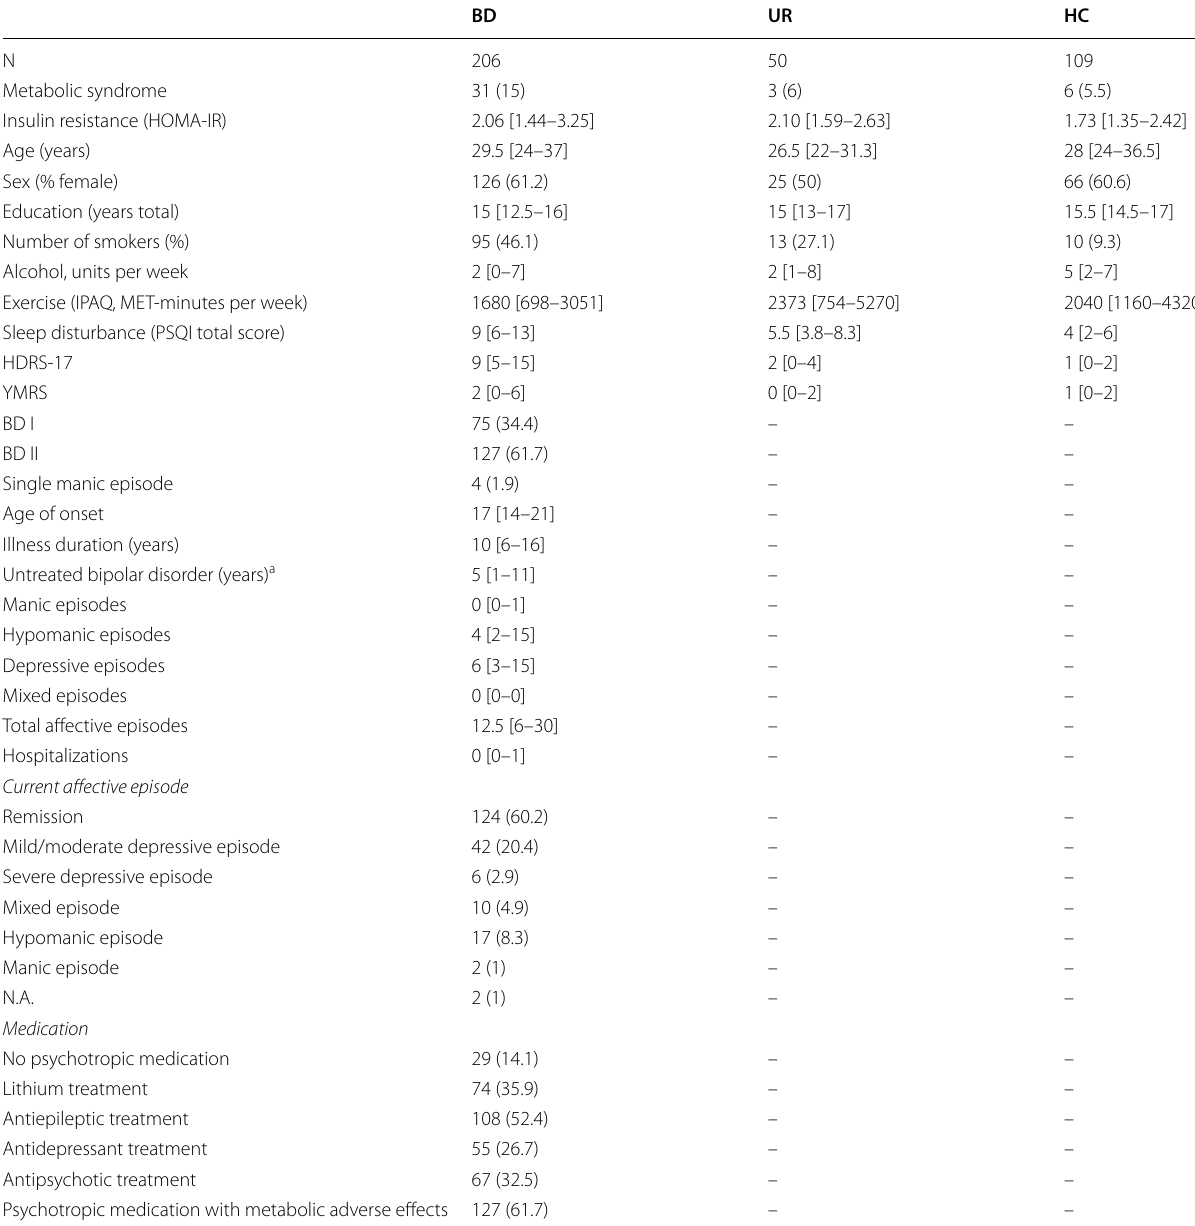
Table 1 Demographic and clinical variables in patients with bipolar disorder (BD), their unaffected first-degree relatives (UR) and healthy individuals